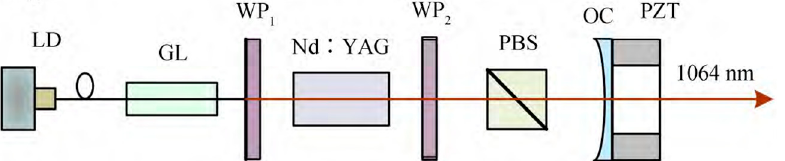
Figure 8. Schematic diagram of dual-frequency Nd:YAG laser with a detuning twisted-mode cavity [24] . LD: laser diode; GL: gradient-index lens; WP: wave plate; PBS: polarizing beam splitter; OC: output coupler; PZT: piezoelectric tube.